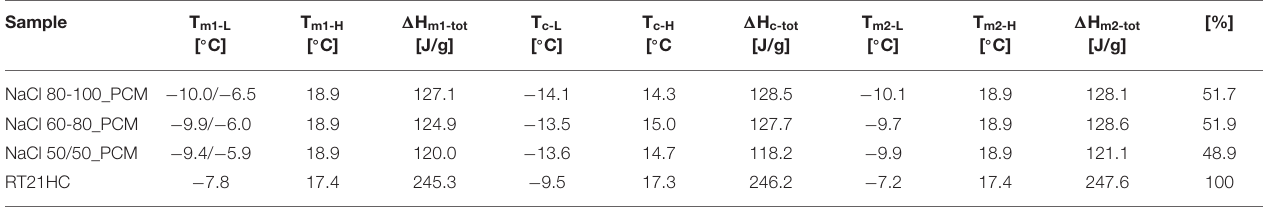
TABLE 6 | Selected data of temperature/enthalpy in the heating-cooling-heating cycle performed in DSC at 1 ◦ C/min. Sample